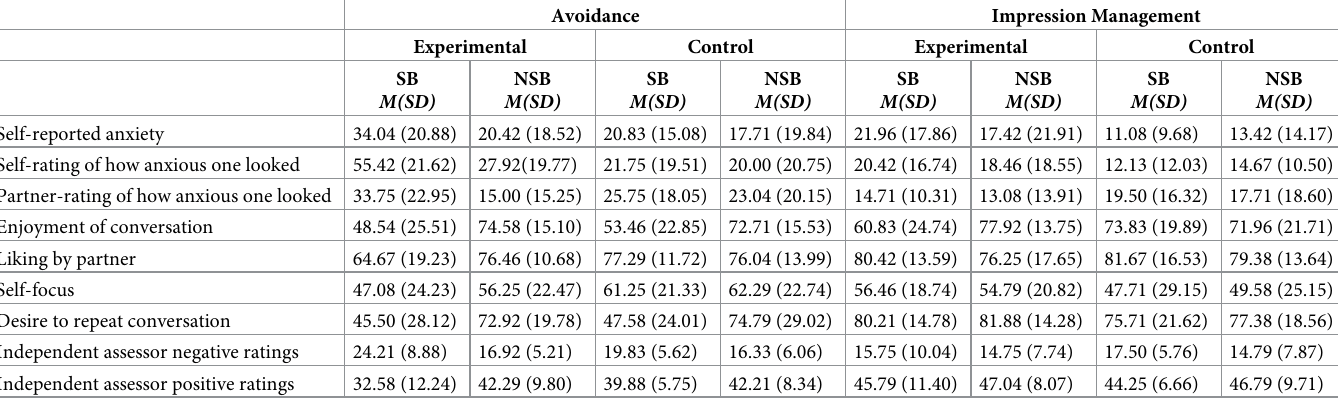
Table 5. Effects of safety behaviour subtypes on self and